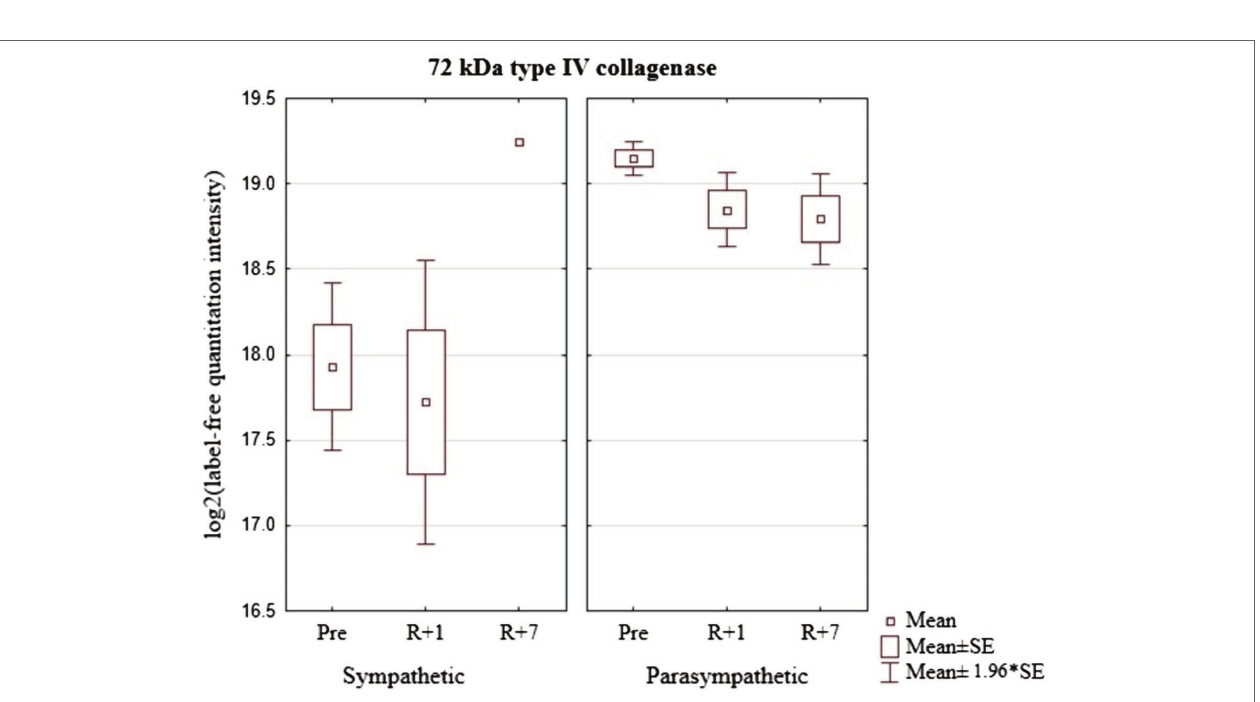
FIGURE 5 | Plasma serine protease inhibitor (Gene-SERPINA5) in cosmonaut groups pre-mission (Pre), on the 1st day (R + 1) and on the 7th day (R + 7) after landing.